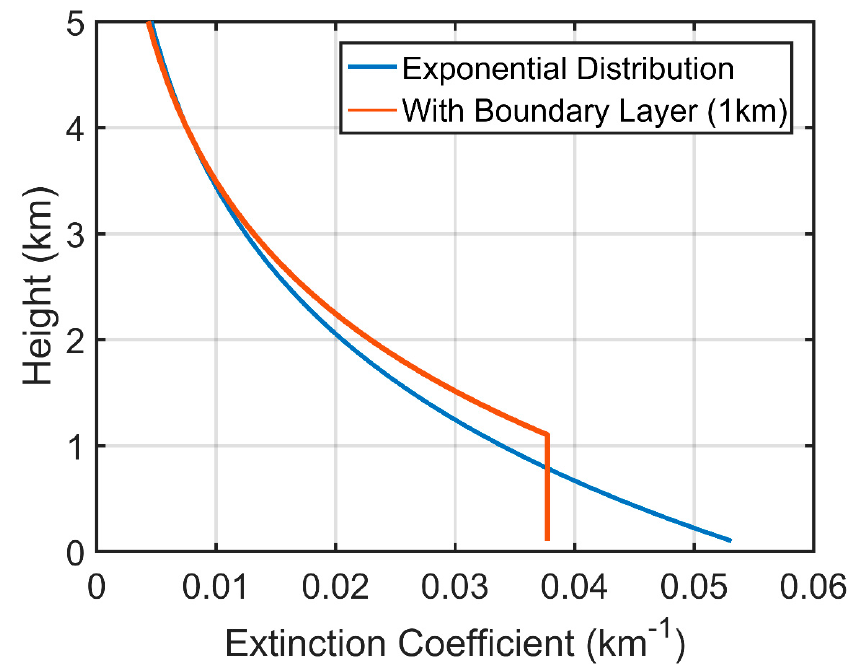
Figure 6. Two types of aerosol vertical distributions: exponential decreasing profile starting from the surface (blue line), and with a 1-km boundary layer near the surface (red